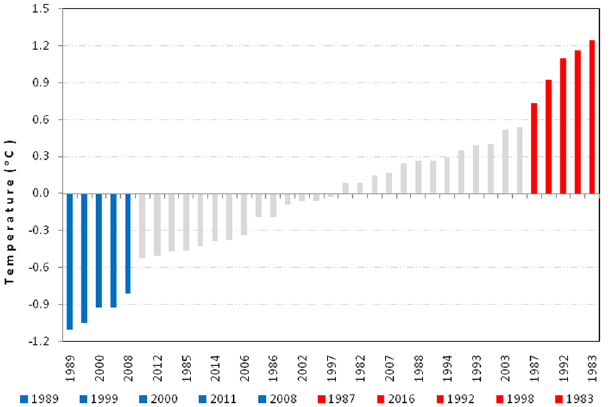
Figure 6. Annual variability of El Nino (red bar) and La Nina (blue bars) episodes based on the Nino 3.4 SST region averaged from December to March from 1979 to 2016. The ENSO extreme events have SST values exceeding ± 0.5 °C and are arranged in accenting order. The Nino 3.4 data were downloaded from https://www.